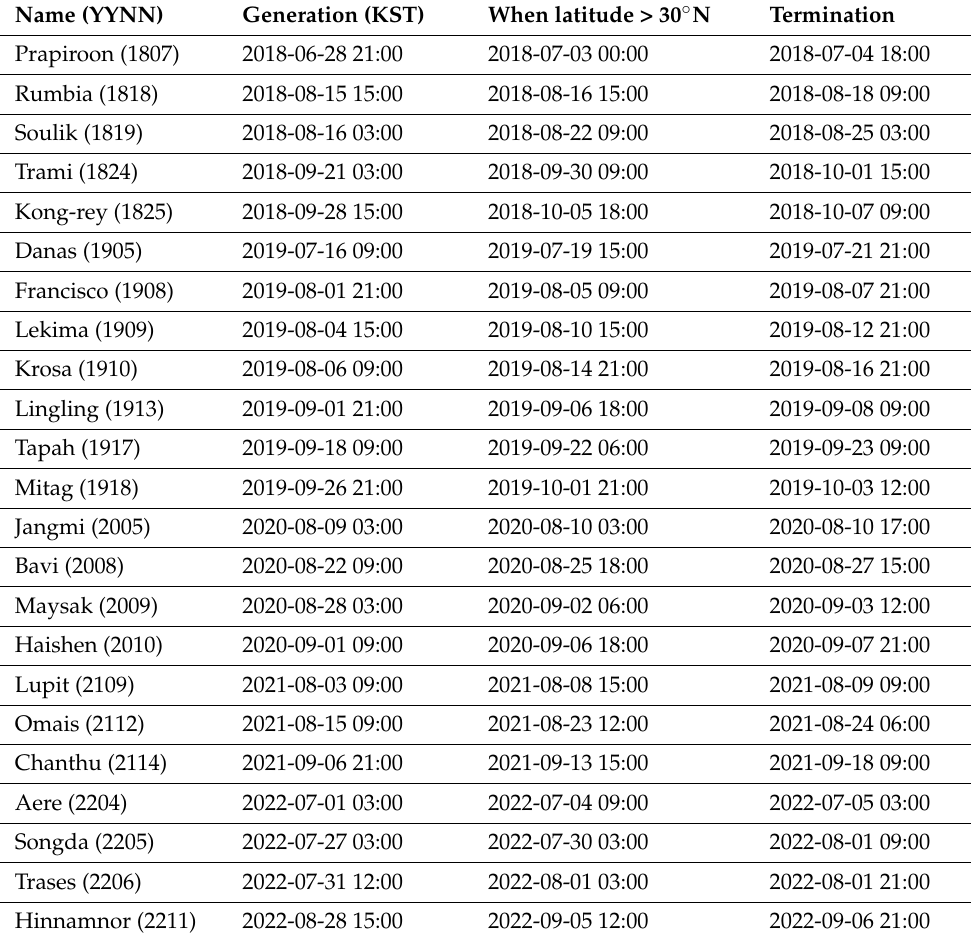
Table 1. Information on typhoons affecting Korea from 2018 to the summer of 2022 based on the KMA best track. The numbers in parentheses beside typhoon names show the order (NN) of typhoon in each year (YY). The time is estimated as Korean standard time (KST), which is UTC+09 hour. Name (YYNN) Generation (KST) When latitude > 30 ◦